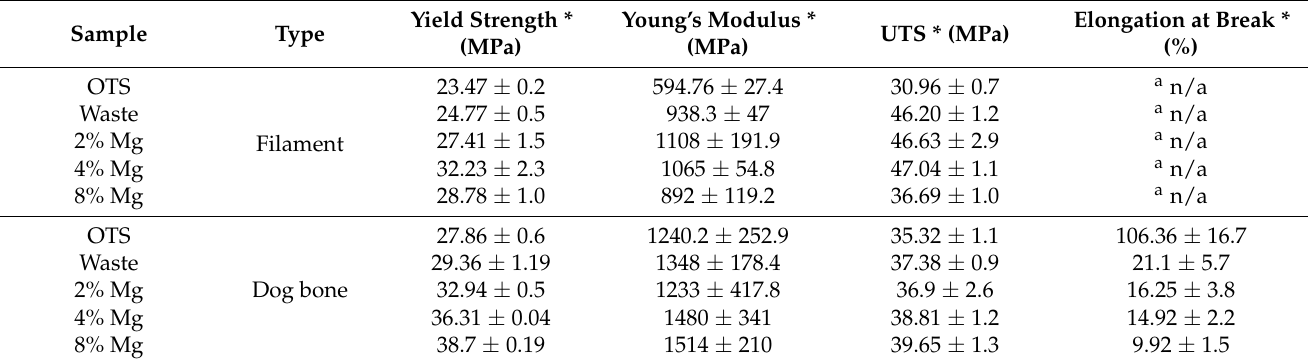
Table 4. Tensile test results for filament and dog bone